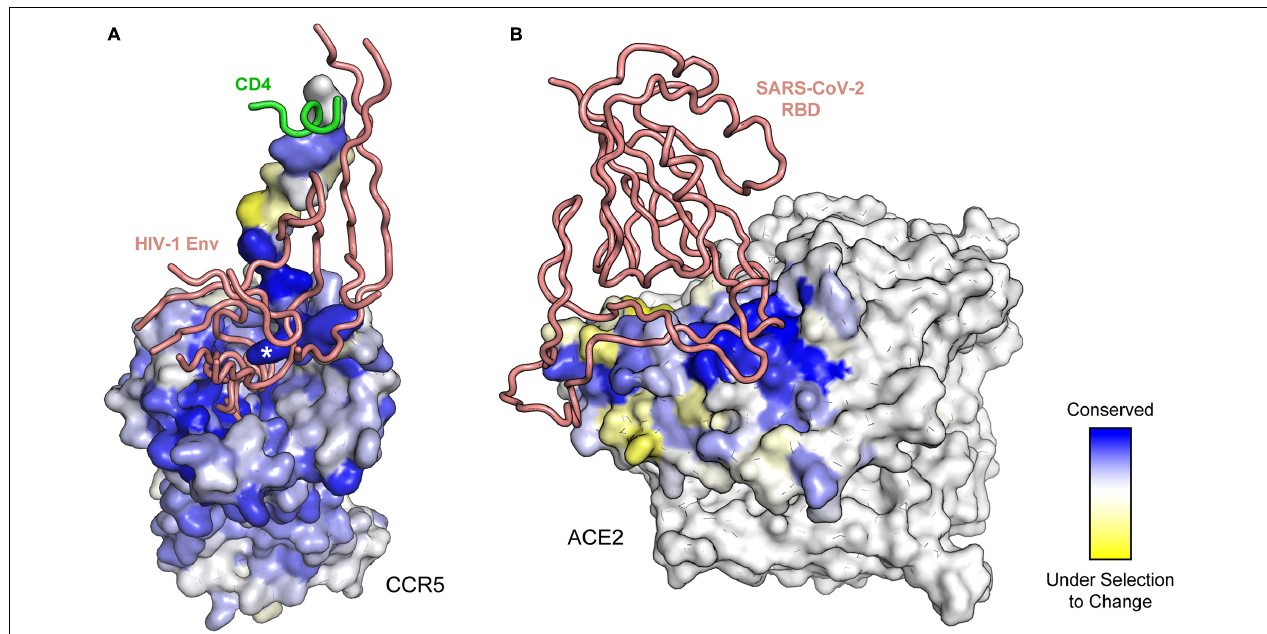
FIGURE 2 | Deep mutagenesis of entry receptors identifies critical binding residues for viral fusion proteins. (A) Conservation from a deep mutational scan of the human immunodeficiency virus 1 (HIV-1) co-receptor CCR5 for interacting with CD4-bound Env is mapped to the structure (PDB 6MEO). For clarity, only residues of Env (peach ribbon) and CD4 (green ribbon) within proximity of CCR5 are shown. Critical CCR5 residues are blue, while residues that are under selection to change are yellow. The asterisk denotes CCR5 sulfotyrosine-14. (B) Deep mutagenesis data of human ACE2 (colored from blue for conserved to yellow for residues under selection to change) binding to the RBD of SARS-CoV-2 (peach ribbon) is mapped to structure (PDB 6M17). In the selection, residue conservation at the interface is bipartite, with one subsite on ACE2 (in dark blue) having very low mutational